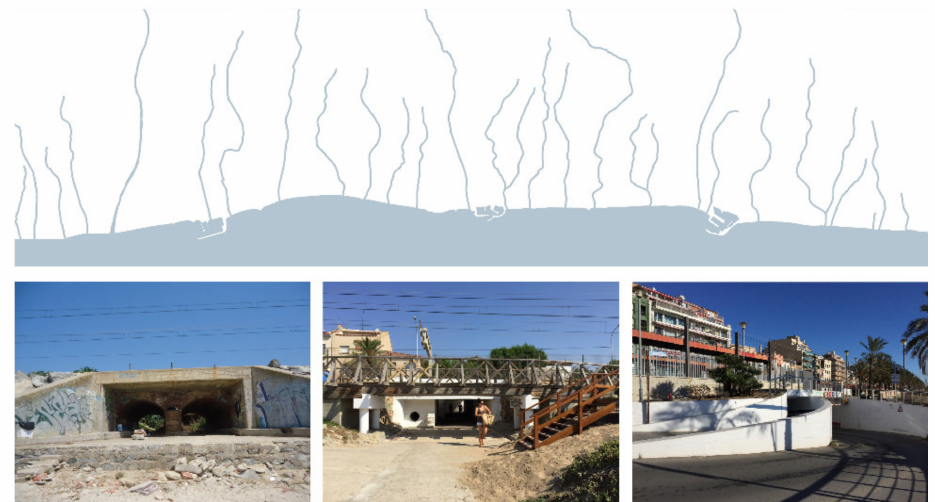
Figure 6. Transversal permeability studies the connectivity between the inland area and the beach, following the streams which cross infrastructures through underground passages (Source: authors’